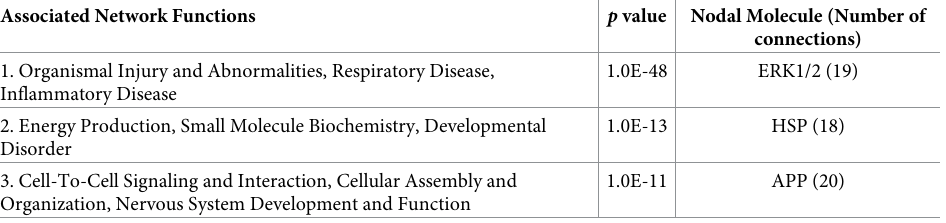
Table 3. Ingenuity pathway analysis (IPA) of the 38 perilymph proteins differentially expressed between patients with normal hearing and those with severe vestibular dysfunction. The three top ranking networks, associated net- work functions, p -values and the nodal molecule with the highest number of connections are shown. Associated Network